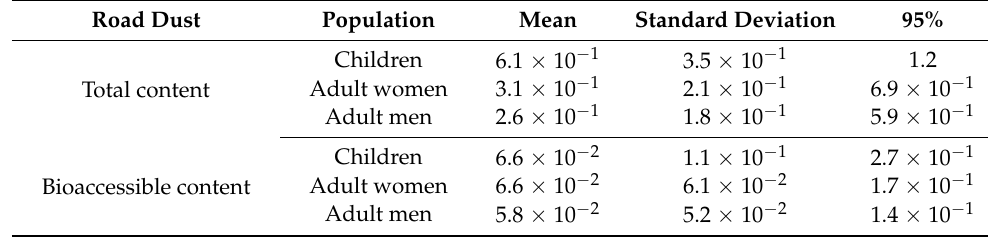
Table 2. Noncarcinogenic risks of trace metals in road dust using total and bioaccessible content.